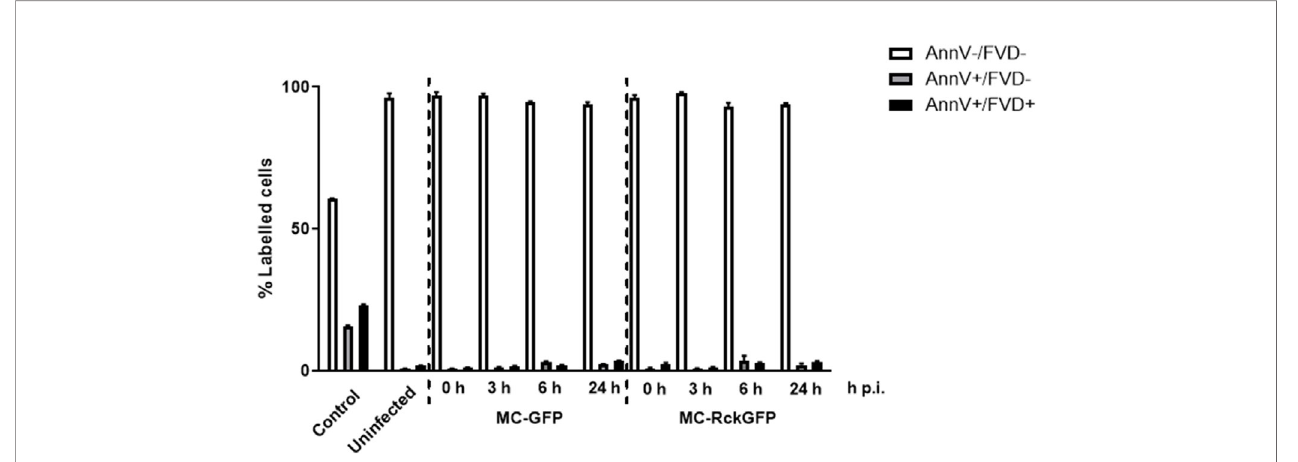
FIGURE 5 | Rck does not induce host cell apoptosis. HCT116 cells were infected with MC-RckGFP or MC-GFP strain for 1 h at a MOI of 100. At the indicated times, a viability assay was performed as reported in Materials and Methods . The data represent the mean ± SD of the percentage of labeled cells with Annexin V- PE (AnnV) and FVD-eFluor780 (FVD). At least 20,000 events were analyzed in triplicate over two independent